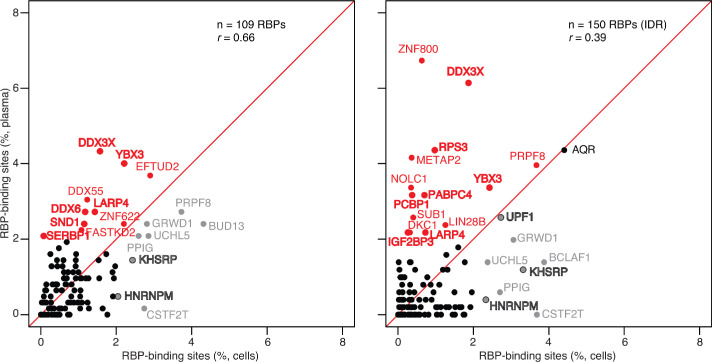
Scatter plot comparing the relative abundances of RBP-binding sites in plasma RNA peaks called against both the human genome and transcriptome reference sequences with those of RBP-binding sites in ENCODE eCLIP cellular RNA datasets (ENCODE 109 RBP eCLIP dataset on the left and 150 RBP eCLIP dataset with irreproducible discovery rate (IDR) analysis on the right; the RBPs whose binding sites were searched are listed in the Supplementary file 1).Abundant RBP-binding sites enriched in plasma or cellular RNAs are indicated in red and gray, respectively. Stress granule proteins are indicated in bold. r is the Pearson correlation coefficient.